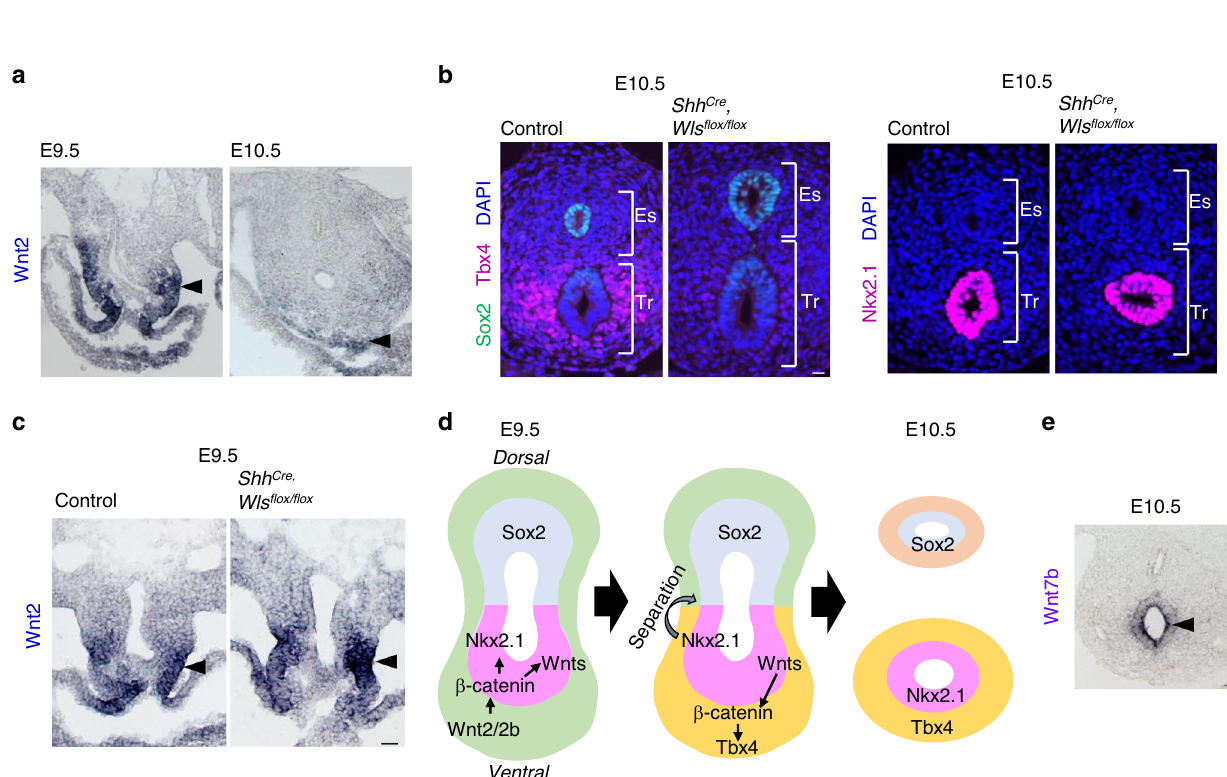
Fig. 2 Wnt signaling is activated to promote mesodermal development of the mouse trachea. a Transverse sections of LEF1 EGFP reporter mouse embryos at E9.5 to E11.5. Sections were stained for EGFP ( green ), Nkx2.1 ( magenta ), and DAPI ( blue ). Arrowheads indicate GFP + cells. n = 3/3 embryos. b Transverse sections of LEF1 EGFP reporter mouse embryos at E9.5 to E11.5. Sections were stained for EGFP ( green ), Tbx4 ( magenta ), and DAPI ( blue ). Arrowheads indicate GFP + cells. n = 3/3 embryos per genotype. c Transversal section of mouse embryo at E10.5. Section were stained for Axin2 ( green ), Nkx2.1 ( magenta ) and DAPI ( blue ) by RNAscope experiment. Arrowheads indicate Axin2 + cells. n = 2/2 embryos. d Transverse sections of Dermo1 Cre , Ctnnb1 fl ox/ fl ox mouse embryos and littermate controls at E10.5. Upper panels show sections stained for Sox2 ( green ), Tbx4 ( magenta ), and DAPI ( blue ). Lower panels show sections stained for Nkx2.1 ( magenta ) and DAPI ( blue ). Arrowhead indicates Tbx4 + cells. Arrows indicate Nkx2.1 + cells. n = 3/3 embryos per genotype. e Three-dimensional imaging of whole trachea and esophagus tissue at E16.5. Cartilage morphology and smooth muscle architecture in the tracheas of Dermo1 Cre , Ctnnb1 fl ox/ fl ox mouse embryos and control littermates. Whole trachea and esophagus were stained for Sox9 ( green ) and SMA ( magenta ). n = 3/3 embryos per genotype. f Model of tracheal architecture in Dermo1 Cre , Ctnnb1 fl ox/ fl ox mouse embryos and control littermates based on e . g Integrative Genomics Viewer (IGV) snapshot of mm10 (chr11:85,884,521-85,904,766) showing mouse tbx4 lung mesenchyme speci fi c element (LME) and compiled ENCODE data of ATAC-seq E14.5 lung (ENCSR335VJW), H3K27Ac E14.5 lung (ENCSR452WYC), H3K4me1 E15.5 lung (ENCFF283EBS), EP300 postnatal day (PND) 0 lung and vertebrate conservation (Phastcons). Numbers indicate fold enrichment over input (ChIP- seq). CisBP and Jaspar predicted Tcf/Lef-binding sites (highlighted in green, region: mm10, chr11:85,893,703-85,894,206) are localized at the ATAC-seq and p300 peaks that are conserved among most vertebrates. Sequence in red shows the Tcf/Lef-binding sites mutated. Eso Esophagus, Lu Lung, Tr Trachea, Tr – E Tracheoesophageal tube. Scale bar: 40 μ m ( a , b ), 50 μ m ( c , d ), 300 μ m ( e ).